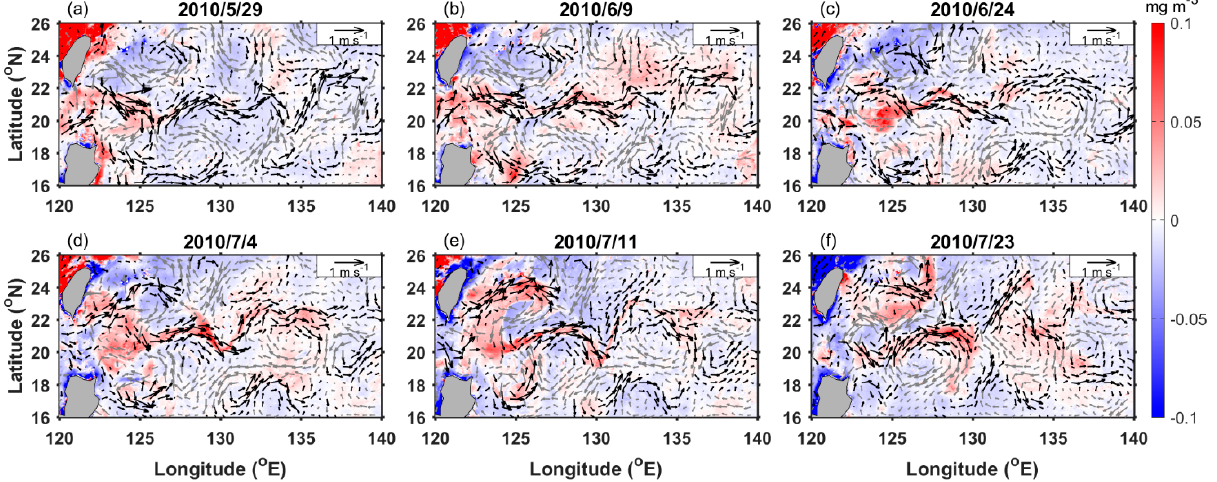
Figure 2. The filament evolution shown as daily 1/24°-gridded chlorophyll-a (Chl-a) anomalies (color shaded) for the selected days ( a ) 29 May, ( b ) 7 June, ( c ) 24 June, ( d ) 4 July, ( e ) 11 July and ( f ) 23 July 2010, in references to the 23 years (1998–2020) daily Chl-a climatological mean. The arrows show the geostrophic velocity anomalies (black for positive zonal velocities and gray for negative zonal velocities) based on the altimetry 1/4°-gridded product. The high Chl-a anomalies located along 21° N within 125° E and 135° E show the footprint of the eastward cross-shore Kuroshio branch (ECKB).